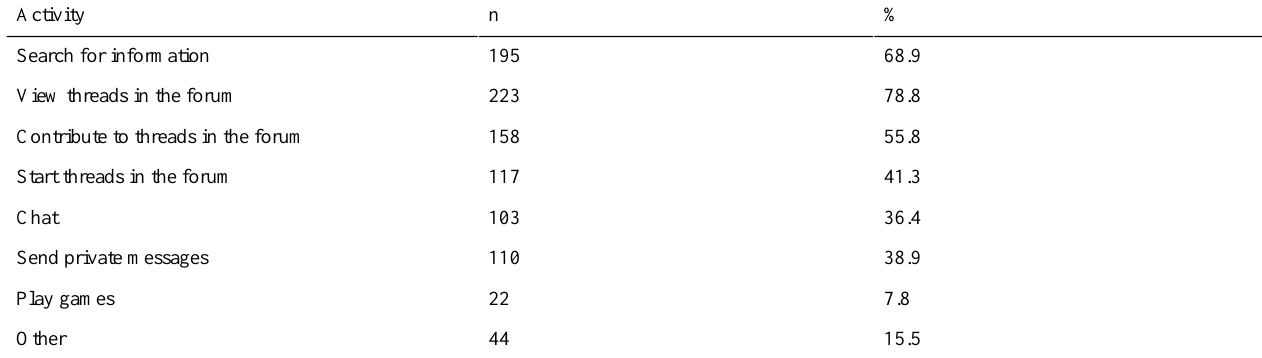
Table 3. Activities carried out when using DSH websites/forums